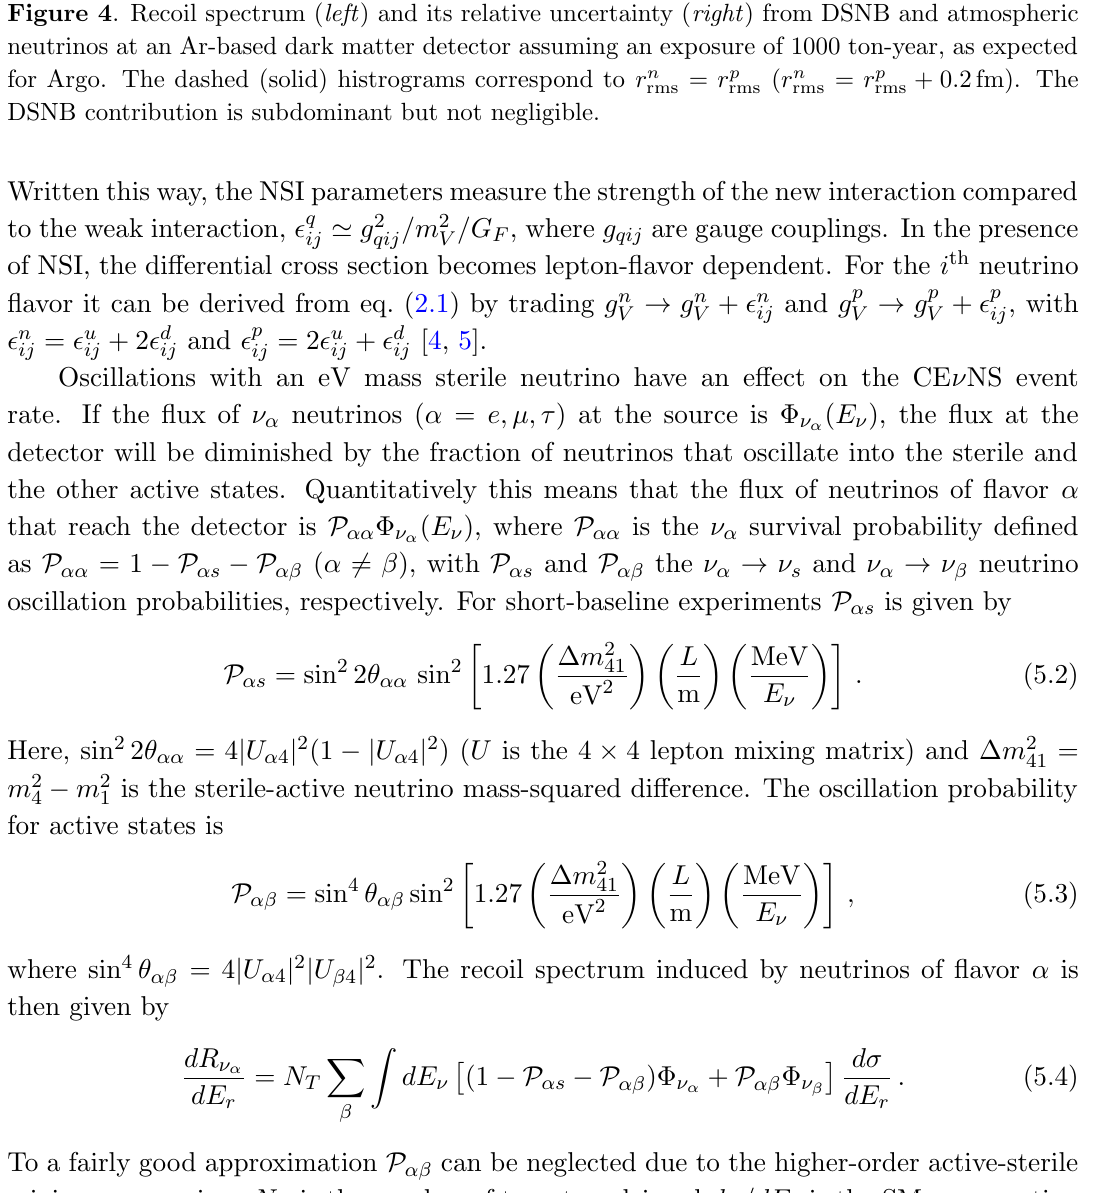
= r p ( r n = r p + 0 : 2 fm). The rms rms rms rms